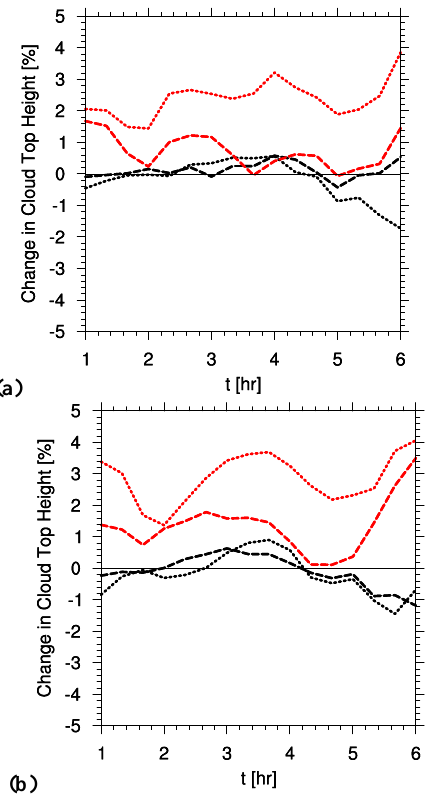
Fig. 17. (a) Average of the vertical velocity profile within the con- vective core and (b) the change in the mean vertical velocity due to changes in CCN number concentration. The convective core is de- fined to contain the columns in which the mean vertical velocity is more than 1ms − 1 . Bulk (black) and bin (red) are displayed on the same graph. The differences are performed for the “Semi-Polluted” (dashed) and “IN-Polluted” (dashed, green and blue for bin and bulk simulations, respectively) cases relative to the “Clean” (solid) case. The vertical axis is different so as to highlight the differences within the cloud itself and because the relative differences at cloud top and above are much larger than those within the cloud. Simulation time is shown in the subcaptions.